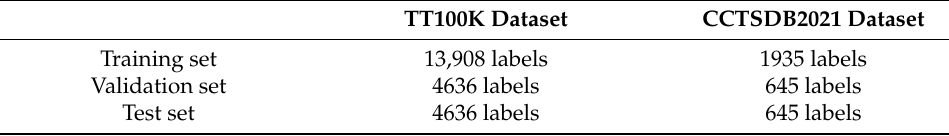
Table 1. Splitting the datasets into training, validation, and test sets.